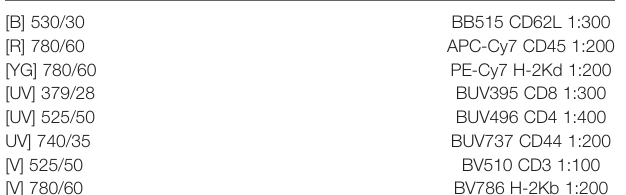
TABLE 1 | Antibody cocktail T cell panel for fl ow